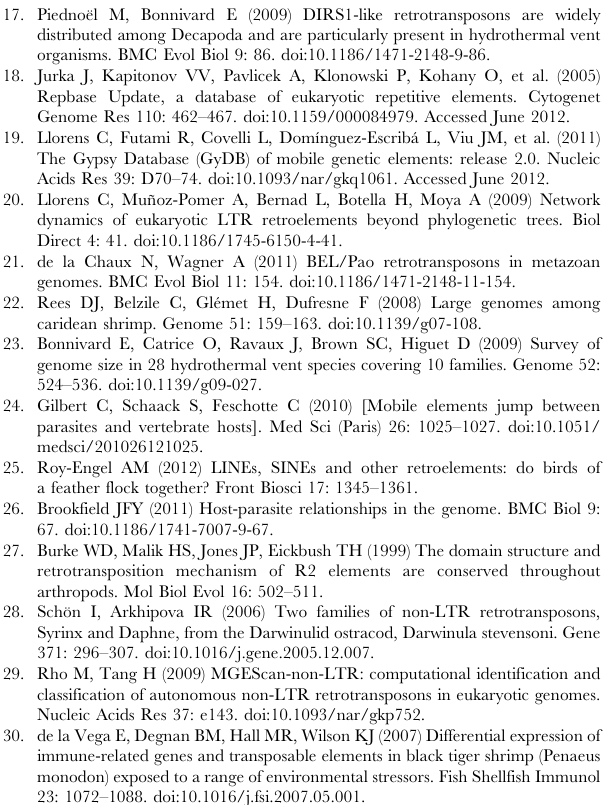
ods: Figure B and SupData E correspond to the phylogenetic analyses; BlastP to the BLAST-based classification method, for which the best GalEa and non-GalEa hits are given with the corresponding E-values. Table S3 Comparison of CD1 and CD2 primers with Copia sequences. Dissimilarities at nucleic or amino-acid levels are indicated in